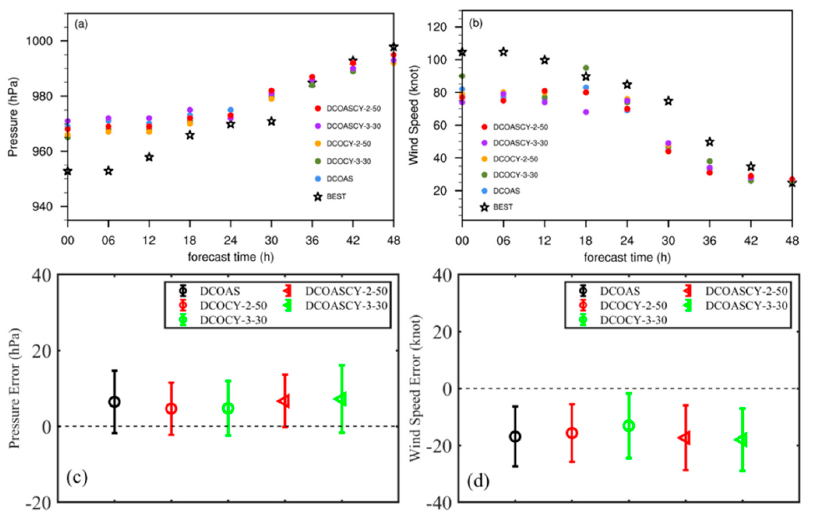
Figure 14. Same as Figure 10, except for intensity forecasts for Delta (0000 UTC 09 to 0000 UTC on